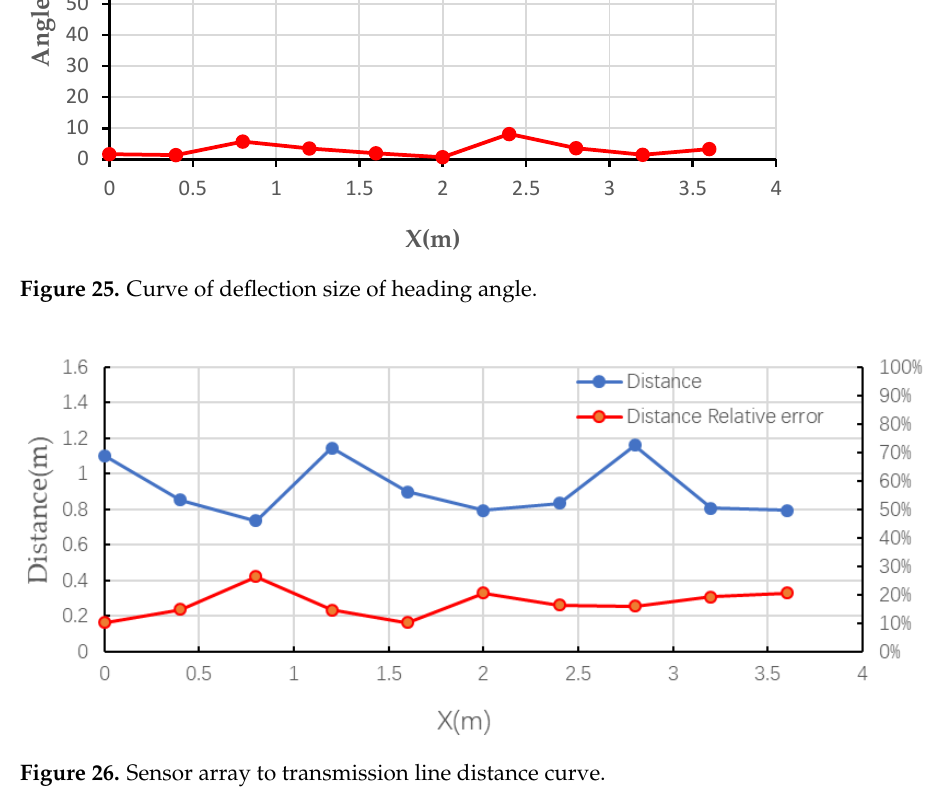
Figure 25. Curve of deflection size of heading angle.